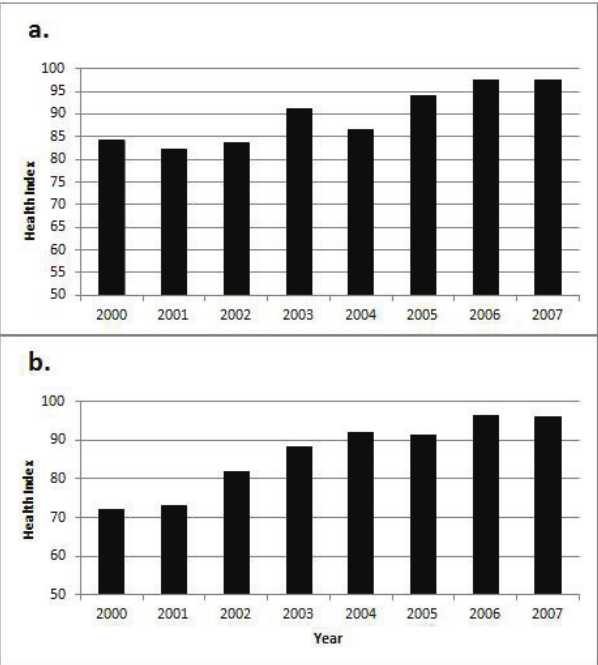
Fig. 4. Annual index of fall (a) and spring (b) Porcupine caribou herd health from 1999–2007 based on Arctic Borderlands